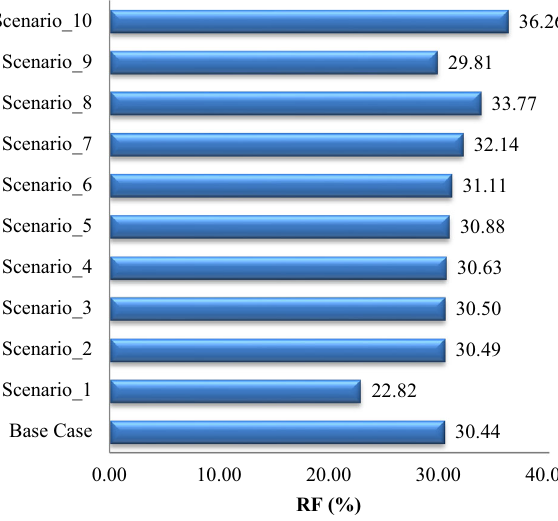
Fig. 23 Comparison of recovery factors in different